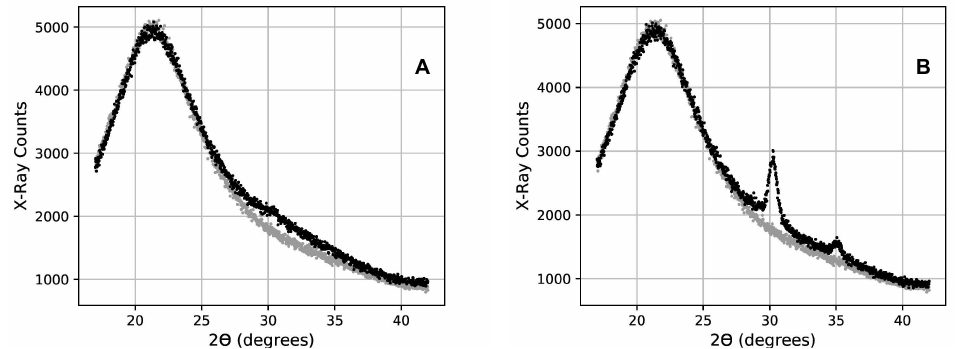
Figure 1. The scan of a sample’s uncoated backside (gray points) is scaled and compared to the scan of a sample’s coated front side (black points). On graph ( A ), crystallization has not started, and the noticeable broad feature is attributed to the bond length and amorphous nature of the material in the coating film. Graph ( B ) reveals crystallization in the same coating sample. This crystallization is highlighted by peaks centered at values governed by the crystal lattice constants and Bragg’s law. The amorphous component has diminished but not disappeared.